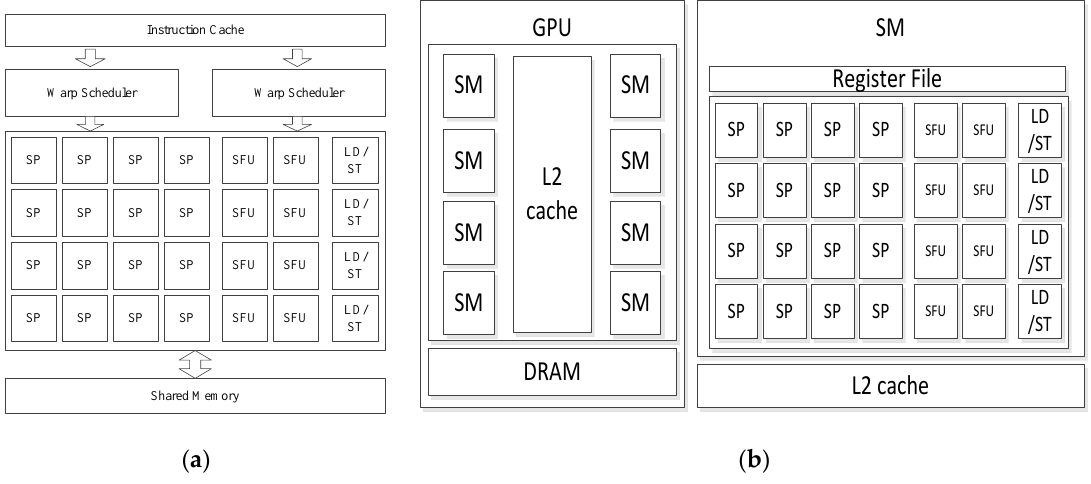
Figure 1. Overview of the Fermi graphics processing unit (GPU) architecture and memory scheme: ( a ) GPU architecture; ( b ) Memory scheme.